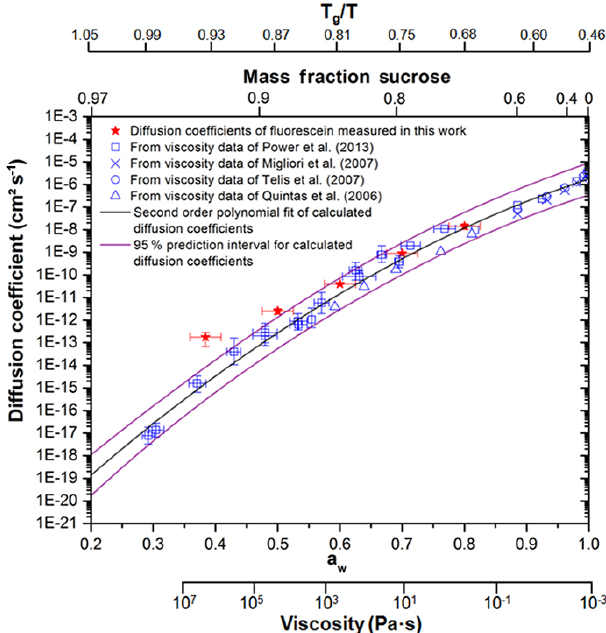
Figure 5. A comparison of measured diffusion coefficients of flu- orescein in sucrose–water films from this work (red stars) with predicted diffusion coefficients based on measured viscosities of sucrose–water solutions and the Stokes–Einstein equation from Power et al. (2013) (blue squares), Migliori et al. (2007) (blue crosses), Telis et al. (2007) (blue circles) and Quintas et al. (2006) (blue triangles). The x error bars for this work correspond to the uncertainty in the determination of a w from the hygrometer. The y errors for this work correspond to 95% confidence intervals from measurement repeats. Several different x axes (wt% sucrose, a w , T g /T and viscosity) are included to help put the results in context. T represents the temperature of the experiment (294.5K), and T g represents the glass transition temperature of sucrose–water solu-